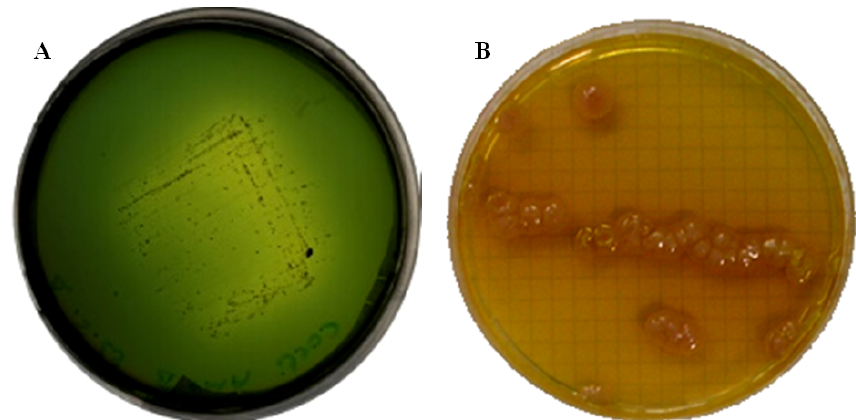
Fig. 4. Indicator plates display pH gradient due to bacterial inoculation after 7 days of growth: S. lividans TK23 on AM medium containing bromothymol blue (A) , neutral pH: green, acidic pH: yellow; S. naganishii P9A-1 on TSB medium containing methyl red (B) , neutral pH: yellow, basic pH: orange.